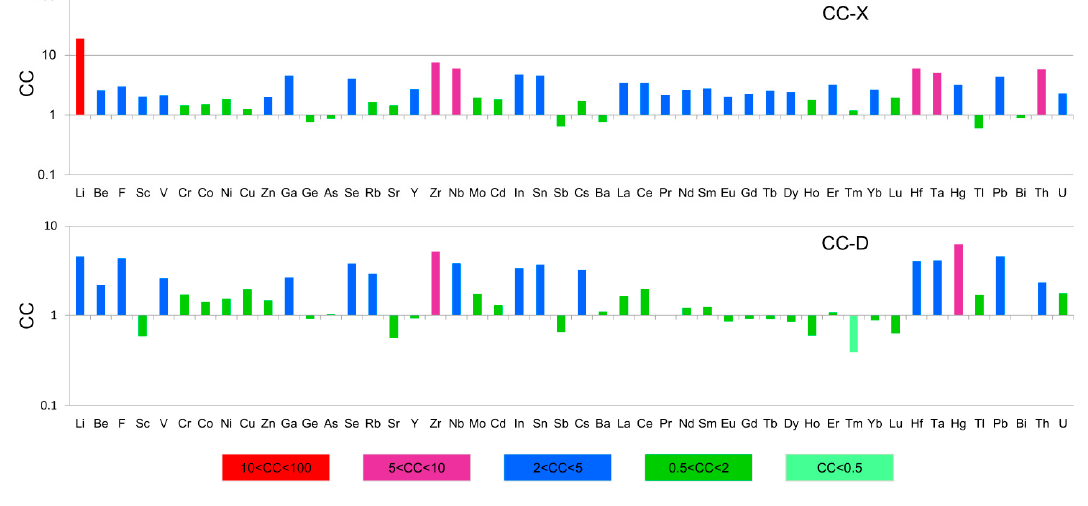
Figure 4. Average concentration coefficient (CC, feed coal vs. world coal) of trace elements in the feed coals from the Xilaifeng (X) and Damo (D) power plants. Table 3. Average concentrations of major (%) and trace ( μ g/g) elements in the feed coals from the Xilaifeng and Damo power plants.